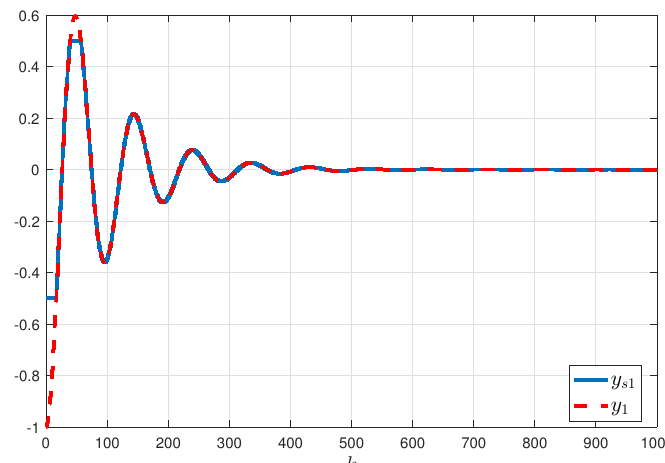
Figure 13. Actual and ideal measurements of y 1 .